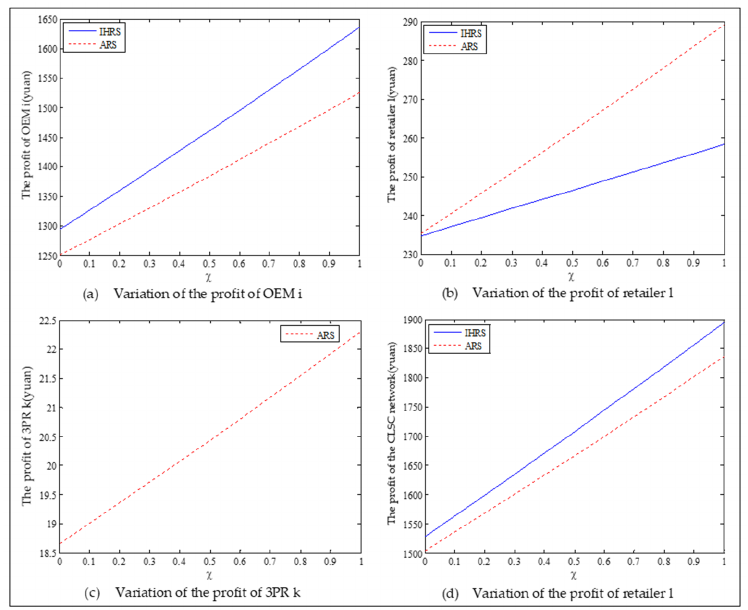
Figure 14. The variation of the profits in Case 1 of Section 6.2.